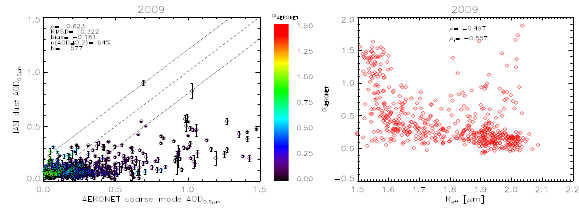
Fig. 8. Left: Evaluation of IASI Dust AOD 0.5µm against AERONET coarse mode AOD 0.5µm. Symbol colours represent AERONET ˚Angstr¨om exponent α . Right: AERONET ˚Angstr¨om exponent plotted over IASI retrieved dust effective